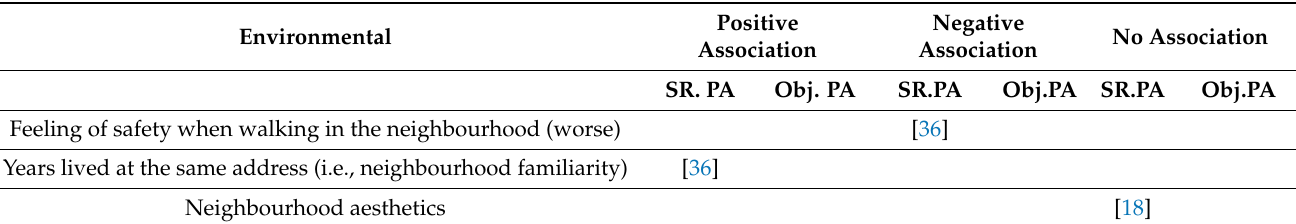
Table 9. Environmental Factors associated with